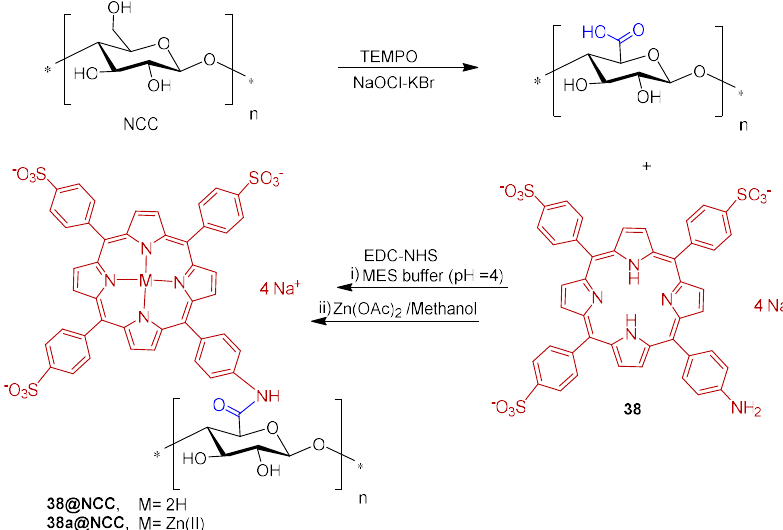
Figure 27. Synthetic methodology used to covalently graft via an amide bond porphyrin 5-(4-aminophenyl)-10,15,20-tris(4-sulfonatophenyl)porphyrin trisodium 38 on oxidized commercial microcrystalline cellulose. (Adapted from reference [183]).